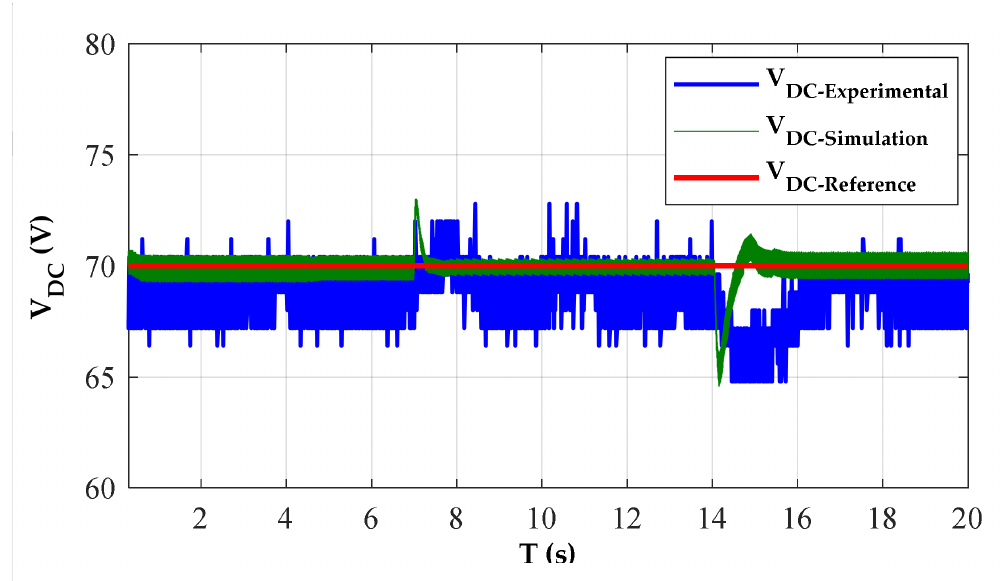
Figure 13. DC bus voltage regulation for different shaft speed, at R L = 333 Ω and V DC-ref = 70